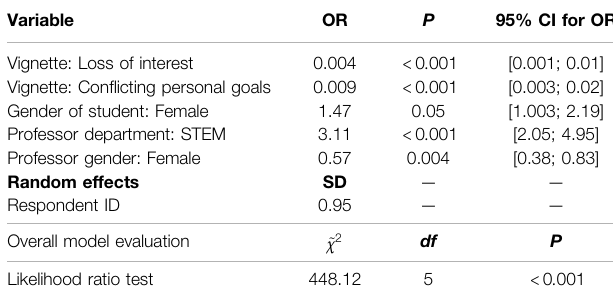
TABLE 1 | Logistic regression predicting whether a professor encourages an undergraduate to follow through with plans to go to physics graduate school. Professors had higher odds of encouraging if the professor was af fi liated with STEM department(s), if the professor was male, when the undergraduate was a woman and when the undergraduate showed signs of “ matching ” with academic physics (baseline condition for the model included the one “ match ” vignette). The likelihood ratio test compares the target model to a null- interceptmodel.Numberoftotalobservations:1,092.Numberofencouraging observations: 692. Number of discouraging observations: 400. Number of respondents: 364. OR (cid:1) odds ratio, P (cid:1) p -value, 95% CI for OR (cid:1) 95% con fi dence interval for odds